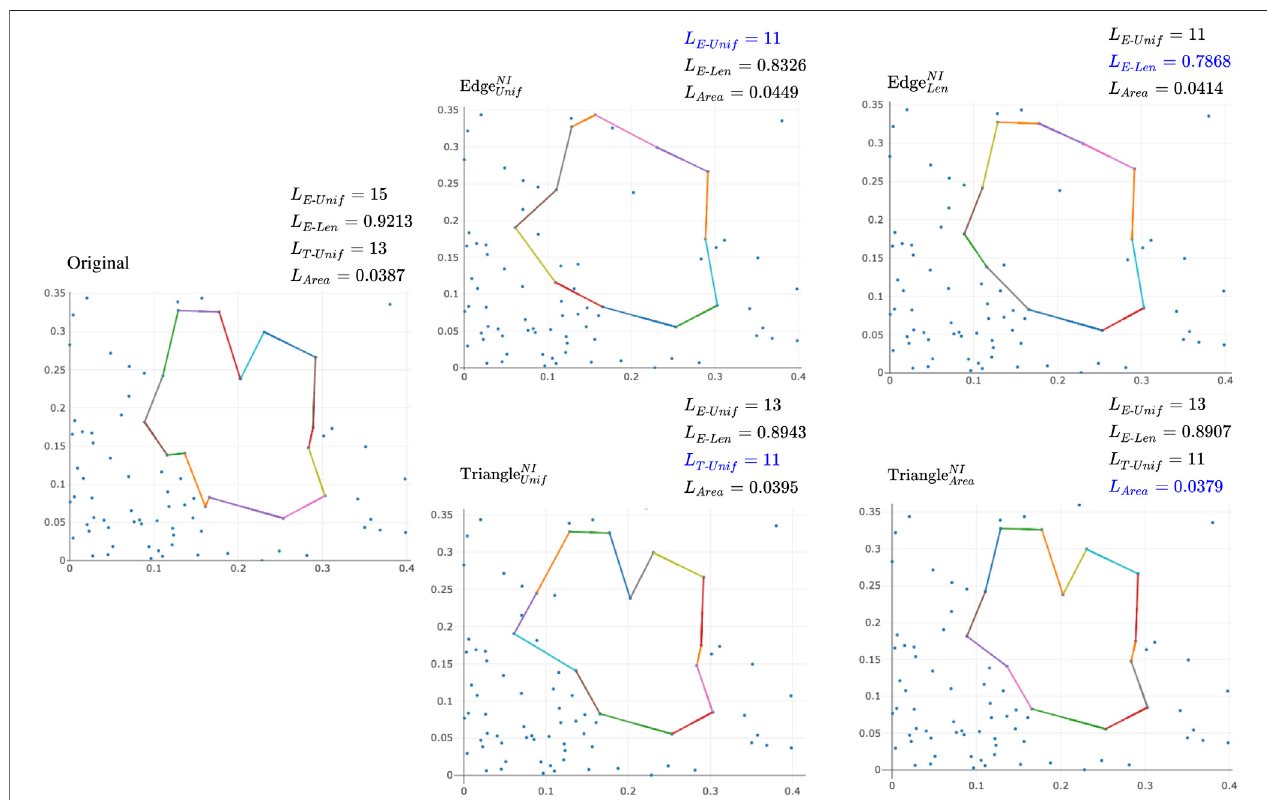
FIGURE7| Examplesofdifferentoptimalcyclesandcostagainstdifferentlossfunctionsusingapointcloudof100pointswithambientdimensiontworandomlydrawn fromanormaldistribution.Theupperleftcornerofeachsub fi gurelabelstheoptimizationalgorithmusedtooptimizetheoriginalcyclerepresentative.Theupperrightcornerof each sub fi gure records the different measures of the size of the optimal representative. Blue text represents the measure an algorithm sets out to